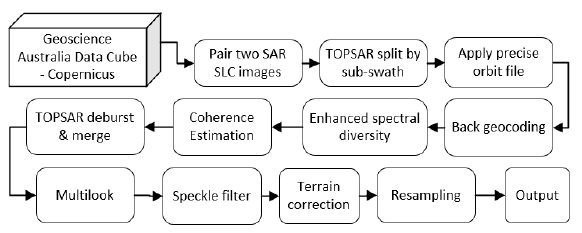
Figure 2. Workflow of InSAR coherence processing